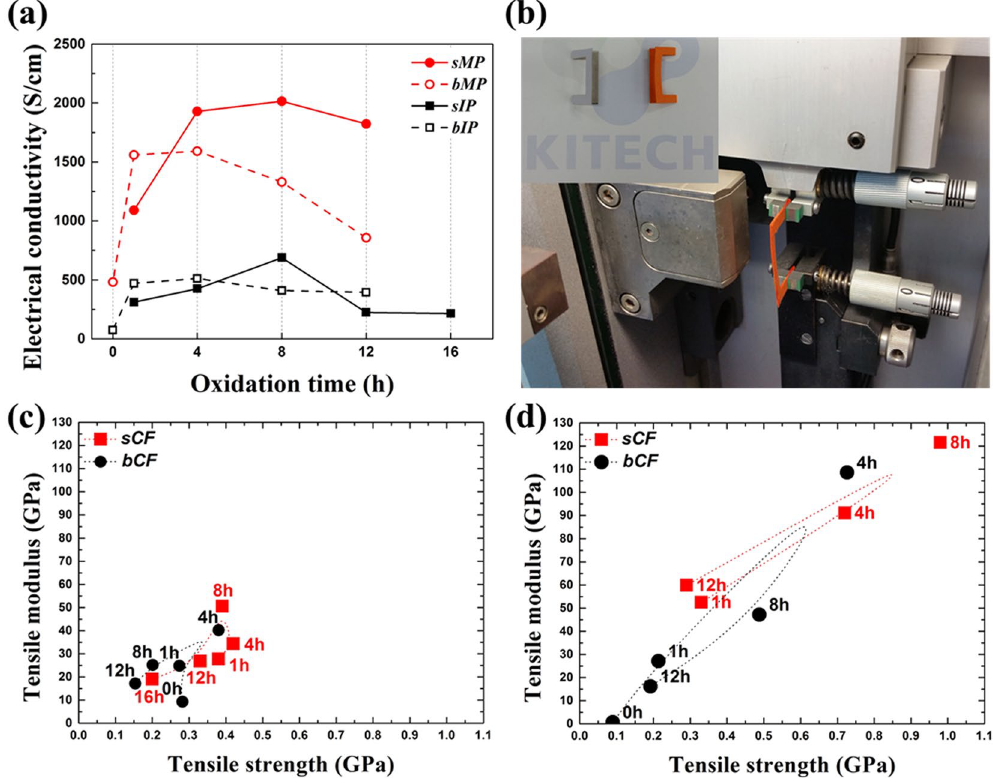
Figure 2. Electrical conductivity of CFs ( a ) and the device for measuring their tensile properties, with an inset image displaying the paper jig ( b ). The mechanical properties of IP-based ( c ) and MP-based ( d )